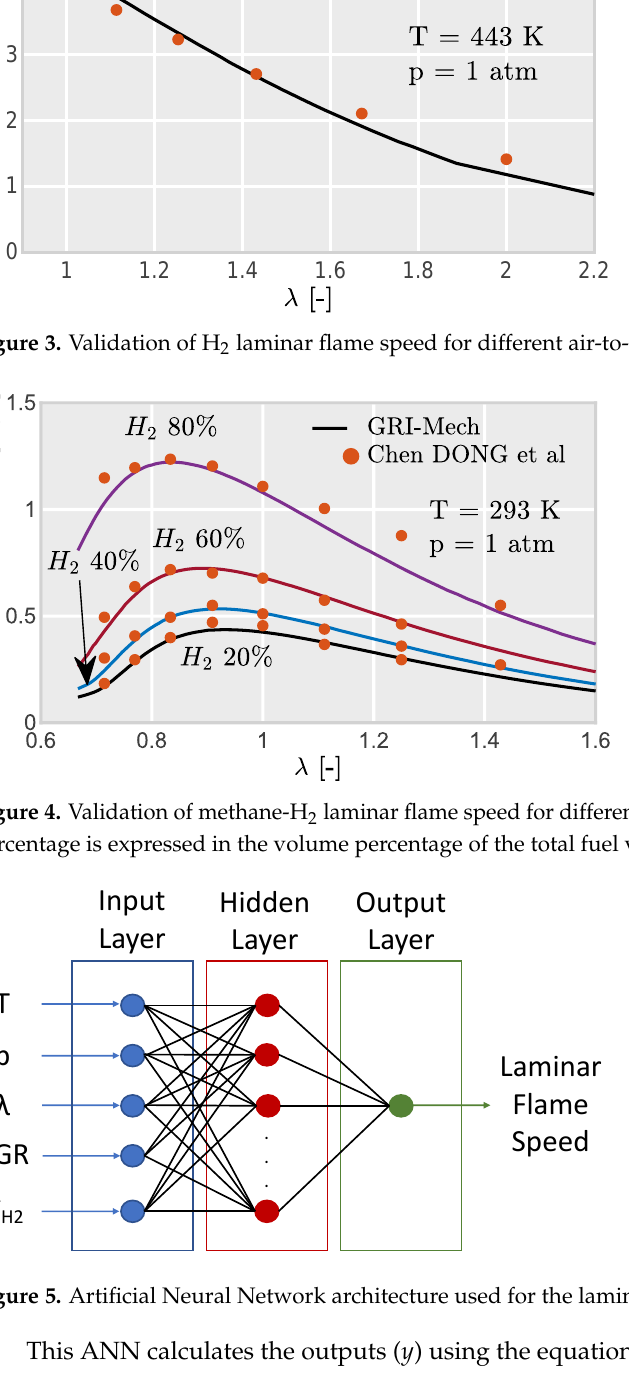
where u is the input data. ( v and a ), ( z and b ) and ( w and c ) are the weights and biases of input, hidden and output layers respectively. Functions g ( x ) and h ( x ) are the activation functions for the input and hidden layers, being both expressed by Equation